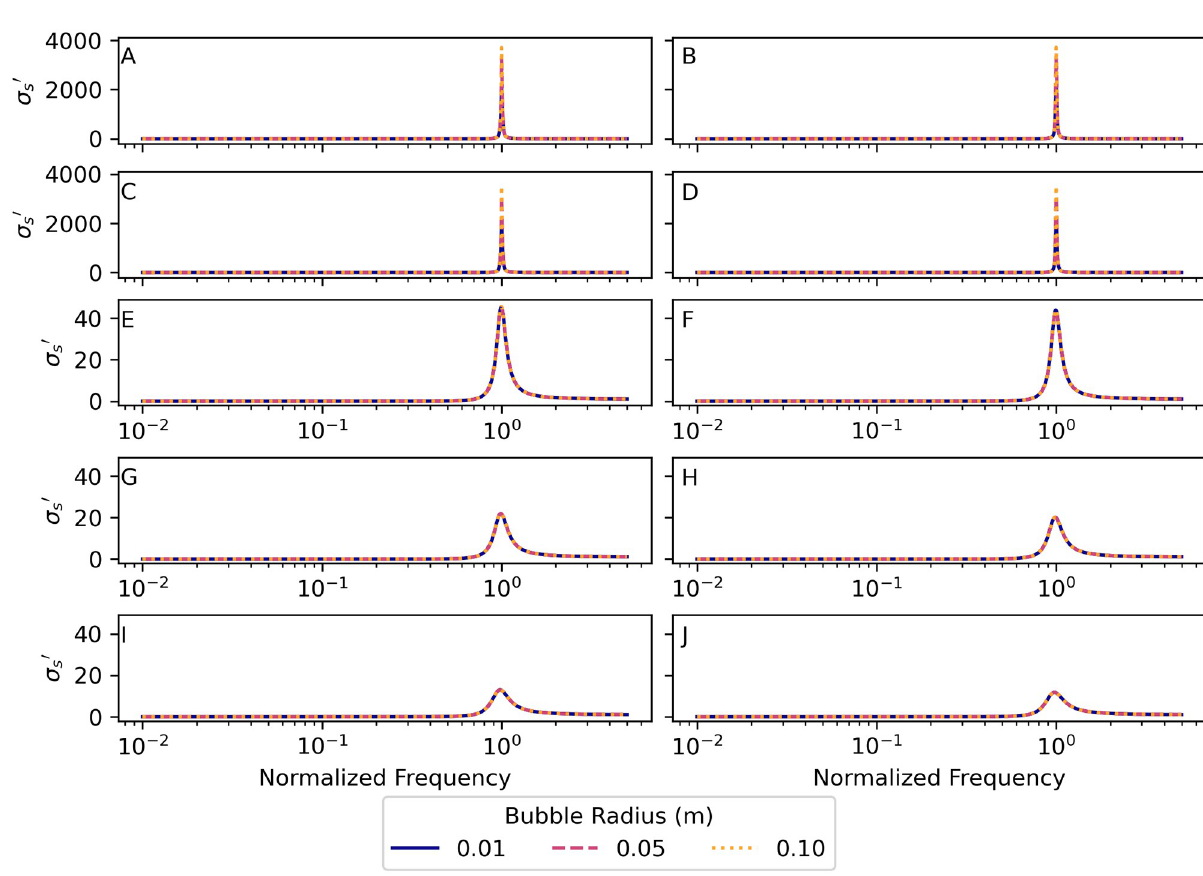
Fig 4. Normalized scattering cross section s 0 vs. normalized frequency for bubbles. Parameter values for each environment are given in Table 1. (A) s Nitrogen bubbles in the warm-surface environment. (B) Oxygen bubbles in the warm-surface environment. (C) Nitrogen bubbles in the cold-surface environment. (D) Oxygen bubbles in the cold-surface environment. (E) Nitrogen bubbles in the 1000 m deep environment. (F) Oxygen bubbles in the 1000 m deep environment. (G) Nitrogen bubbles in the 2000 m deep environment. (H) Oxygen bubbles in the 2000 m deep environment. (I) Nitrogen bubbles in the 3500 m deep environment. (J) Oxygen bubbles in the 3500 m deep environment. Note that the vertical axis scales in subplots A–D are different than those in subplots E–J. The normalized scattering cross-section curves for all bubble radii in each environment are identical for each gas. See sections 8.1–8.3 in S3 and S4 Files for the calculations used for this